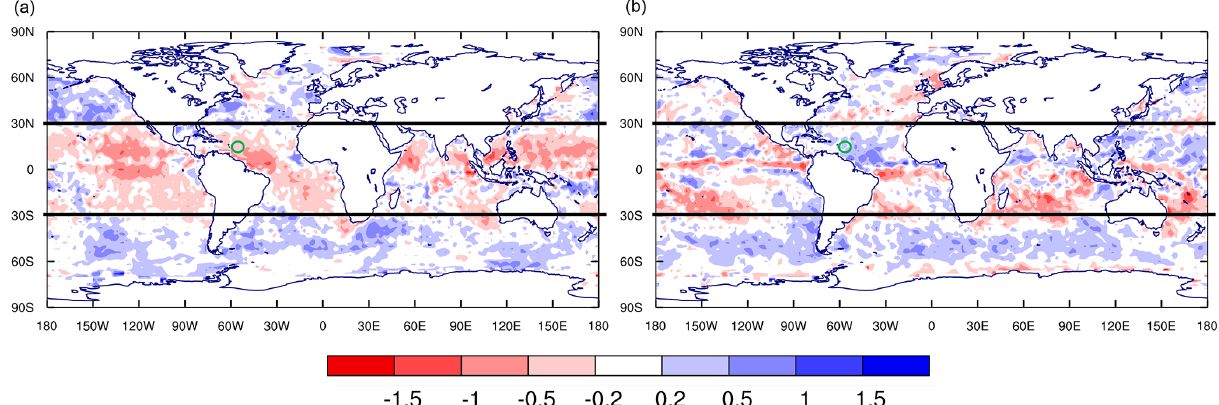
Figure 1. Surface wind bias with respect to ASCAT in the ECMWF operational deterministic forecasts for the months of January and February 2020. The green circles include the study area of EUREC 4 A. Panels (a) and (b) refer to the zonal and meridional wind components,